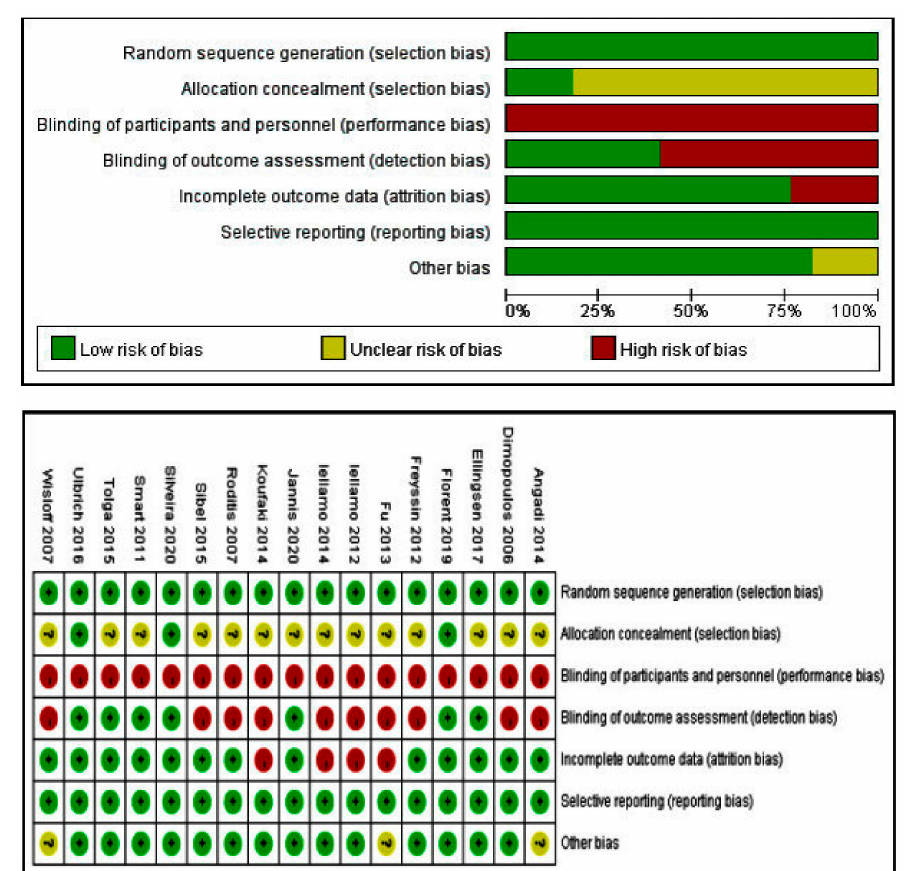
Figure 2. Analysis of the risk of bias in accordance with the Cochrane collaboration